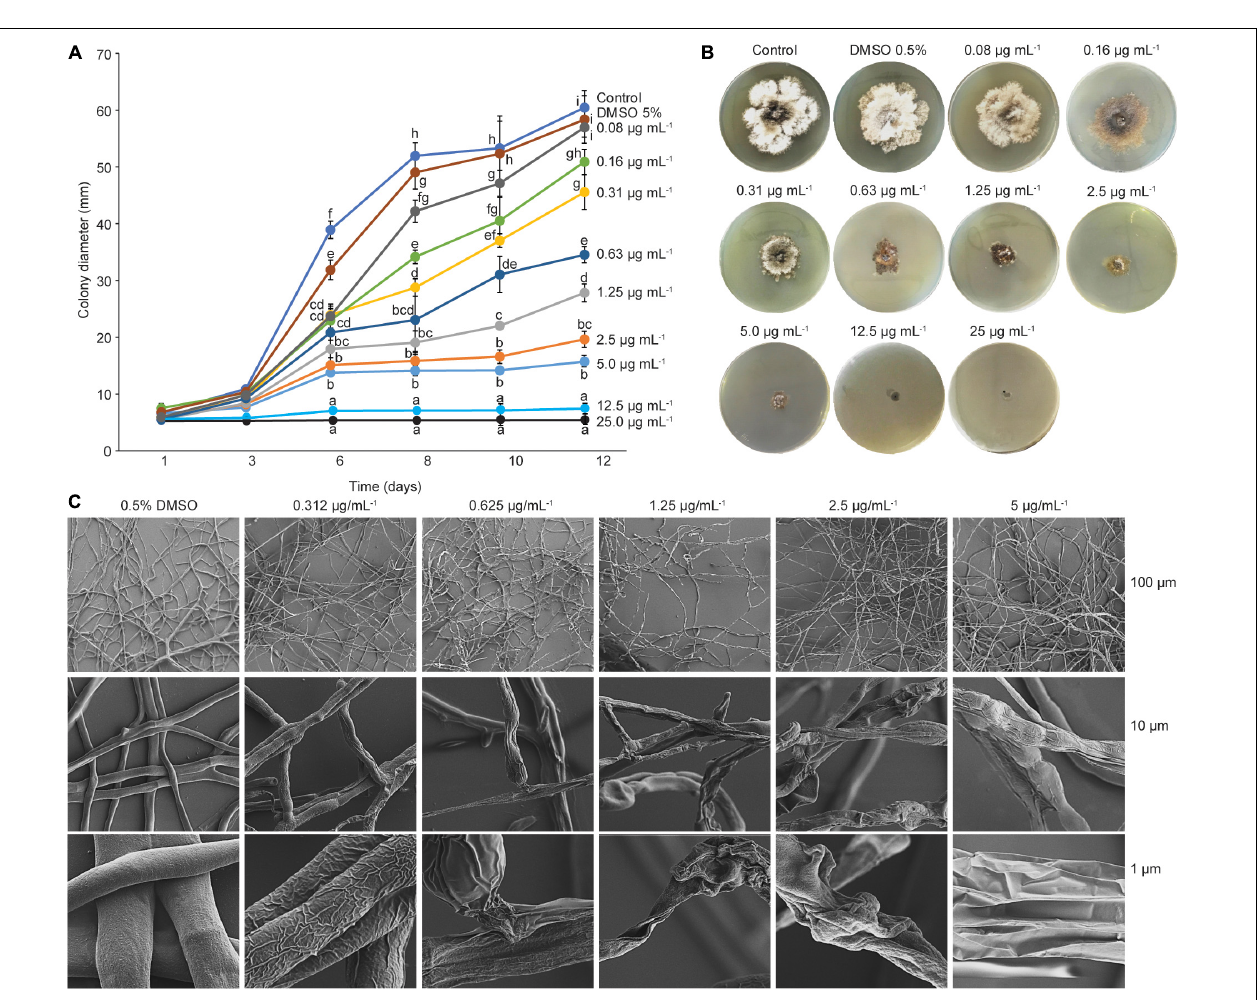
FIGURE 6 | Minimum inhibitory concentration and scanning electron microscopy. (A) Minimum inhibitory concentration (MIC) of PCA. Graphic represents the effects of different PCA concentrations on fungal growth at different incubation time. Fungal growth decreased at a concentration of 0.08 mg ml − 1 PCA, and complete inhibition of mycelial growth was observed at 25 and 12.5 mg ml − 1 . Different letters indicate significant differences determined by one-way ANOVA, followed by a Fisher PLSD post-hoc test ( p < 0.05). (B) MIC assay after 12 days of incubation at 28 ◦ C. (C) Scanning electron microscopy (SEM) images of the effect of PCA against D. sarmentorum